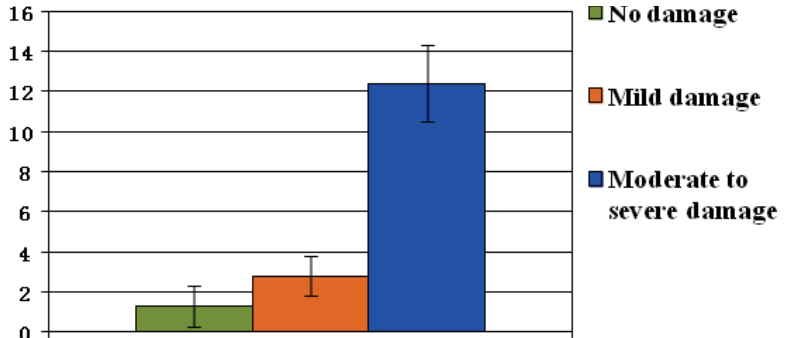
Figure 4. Symptoms of acute stress by level of property